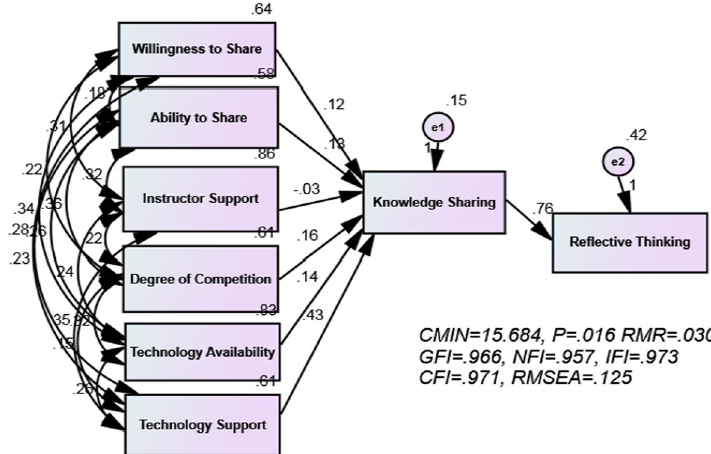
Fig. 2 The final model A with six subscales